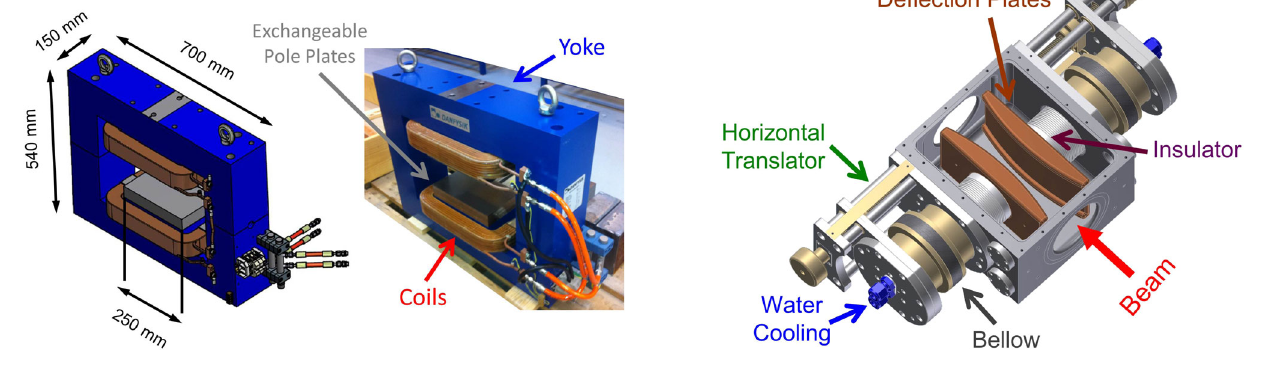
FIG. 8. Main components of the electric deflection unit for the E × B